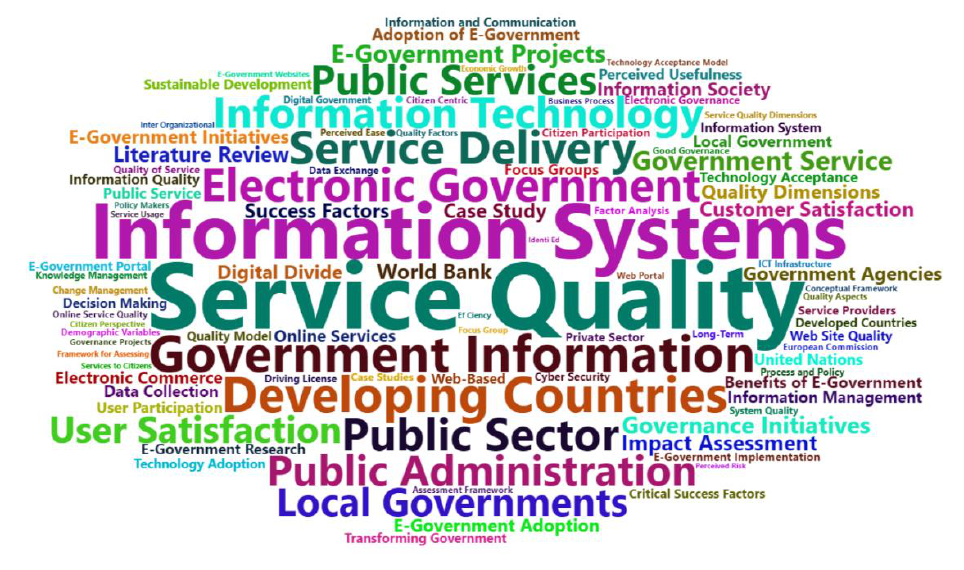
Figure 8: Phrase-cloud from the selected